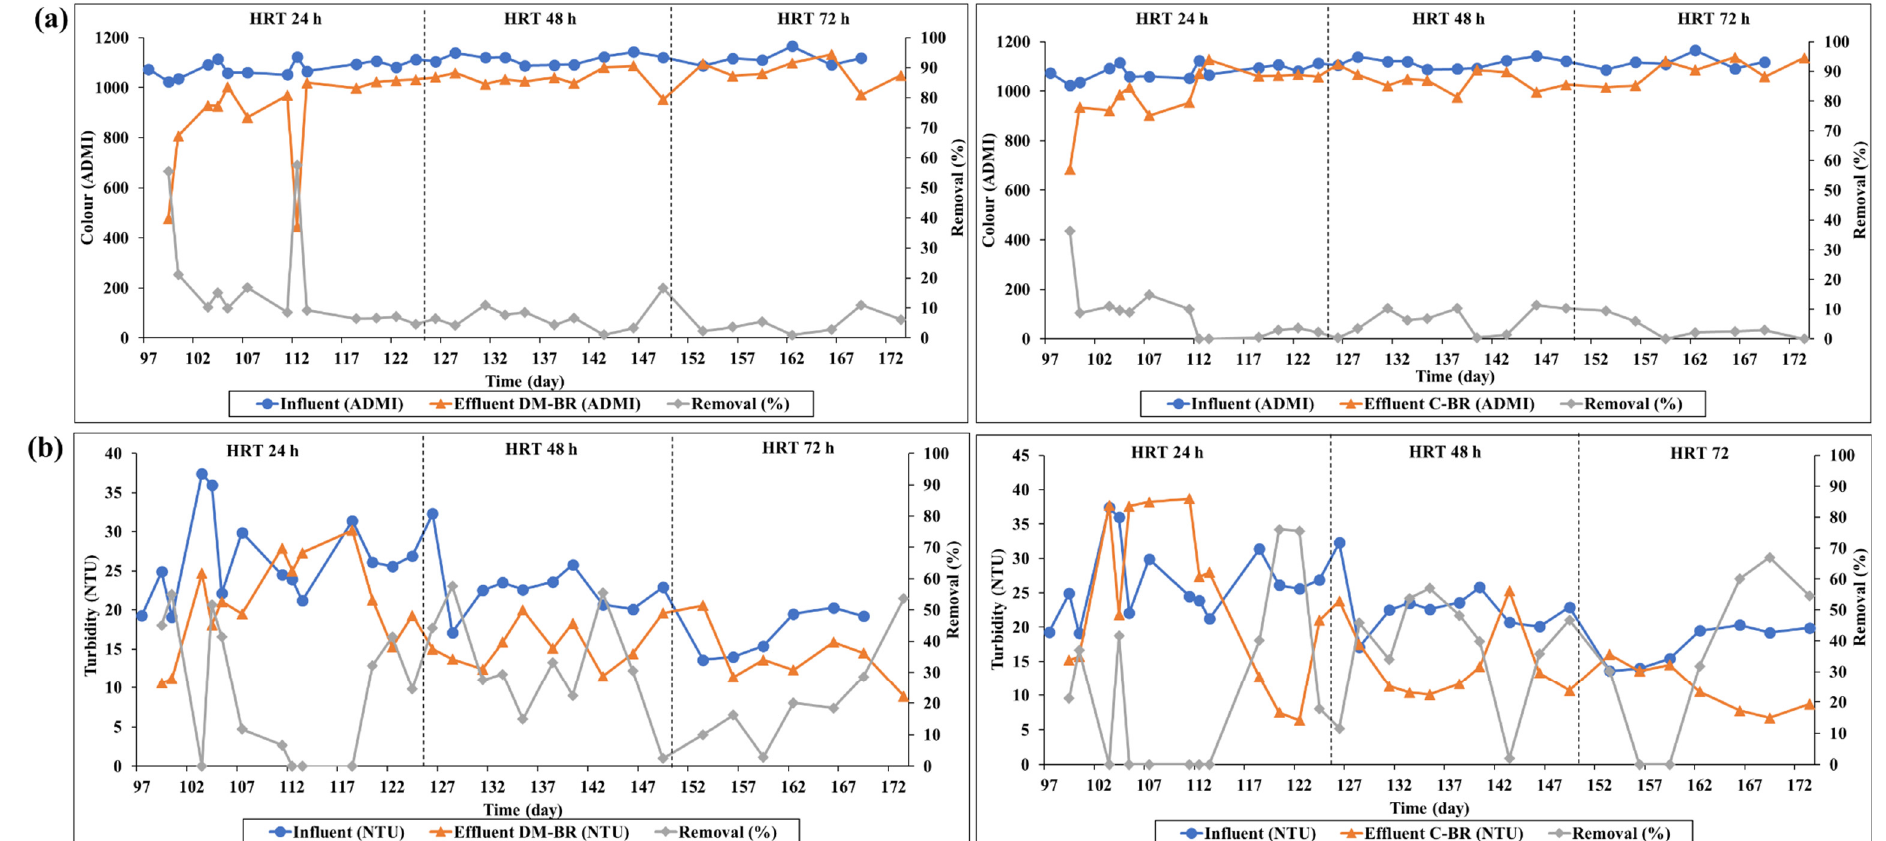
Figure 4. Removal of ( a ) colour and ( b ) turbidity in the DM-BR (left) and the C-BR (right).